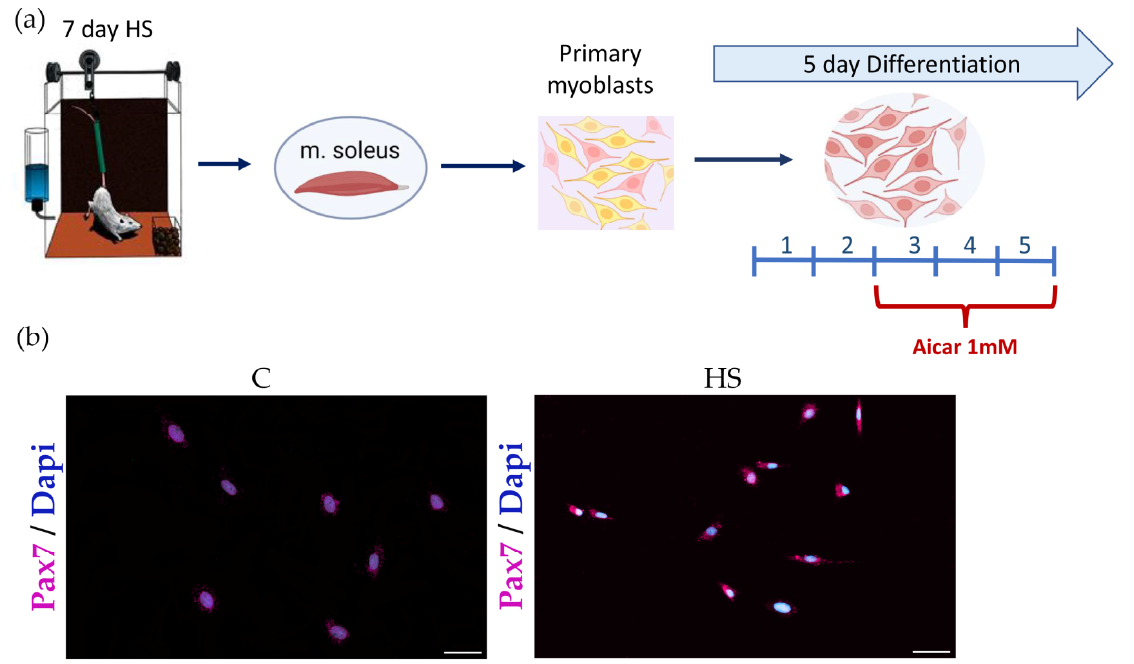
Figure 1. Experimental design. ( a ) Pax7 immunostaining in soleus-derived myoblasts (24 h in culture) and ( b ) Seven arbitrary fields were counted using a 20× objective. Approximately 93% of the cells are Pax7 positive. Pax7: violet, DAPI: blue. Scale bar = 50 μm.